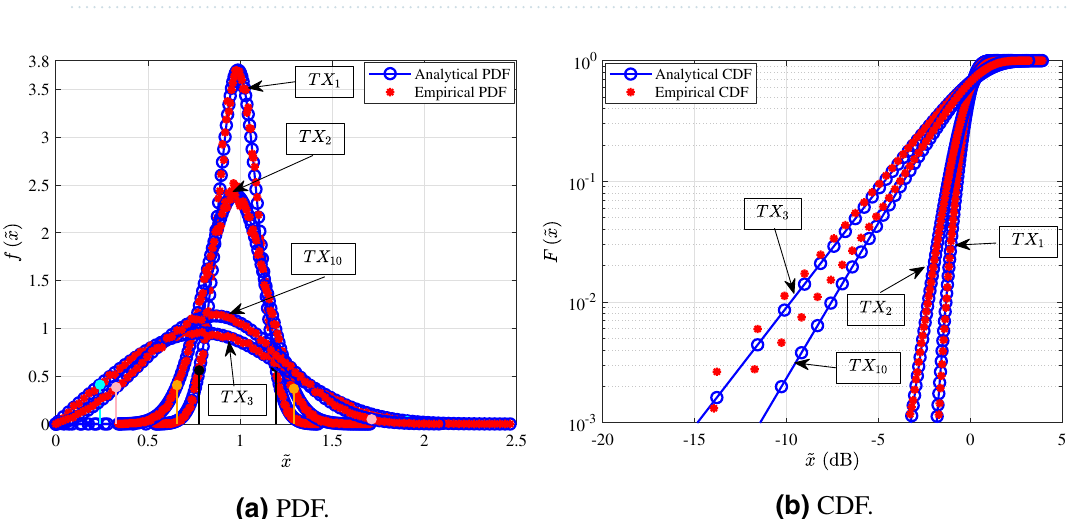
Figure 6. Fitting of PDF and CDF analytical expressions to the empirical channel gain data measurements of some indicative links (1, 2, 3 and 10) of the entrance hall of Aalto